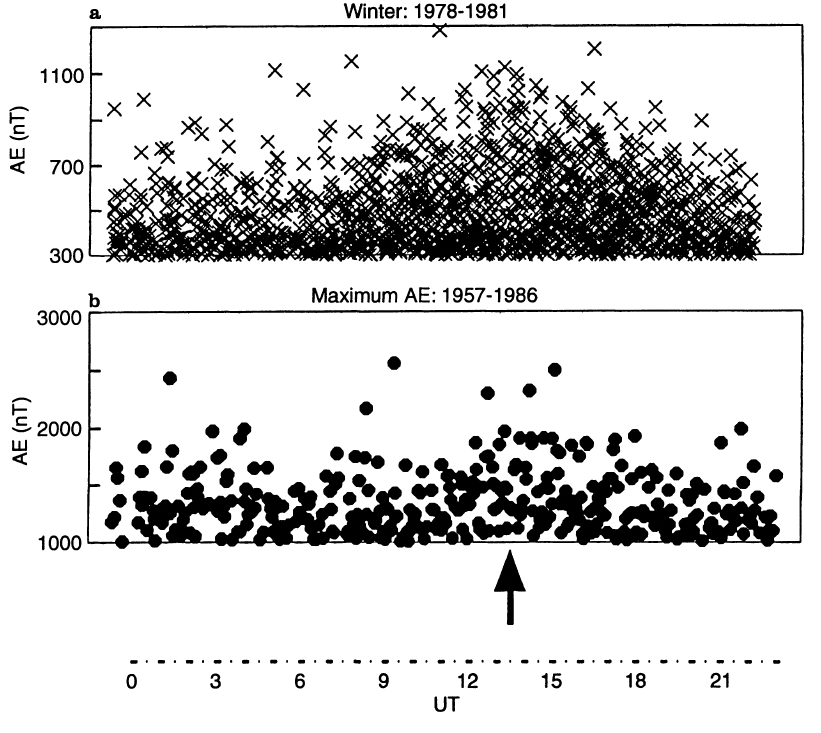
Fig. 5a,b. A scatter diagram of all the hourly AE-indices for winters 1978–1981 as well as a scatter diagram of all the hourly values of AE-index in a range of values: 1000–2500 nT, for two solar cycles